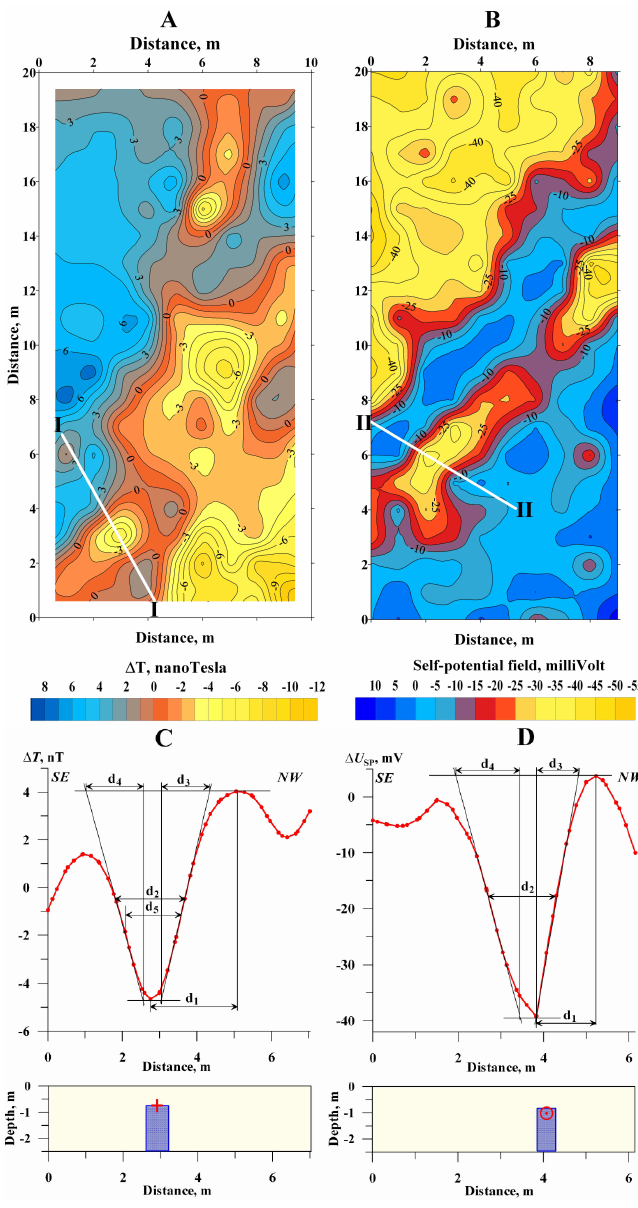
Fig. 13. ( A ), ( B ) maps of magnetic ( A ) and self-potential ( B ) fields in the Halutza site (Negev desert, Israel) ( C ), ( D ). Results of the quantitative interpretation for profile I–I ( C ) and II–II ( D ). A cross indicates the position of the middle of upper edge of anomalous body for magnetic anomaly (C) , and a small circle is inscribed in the upper edge of anomalous body for the SP anomaly (C)